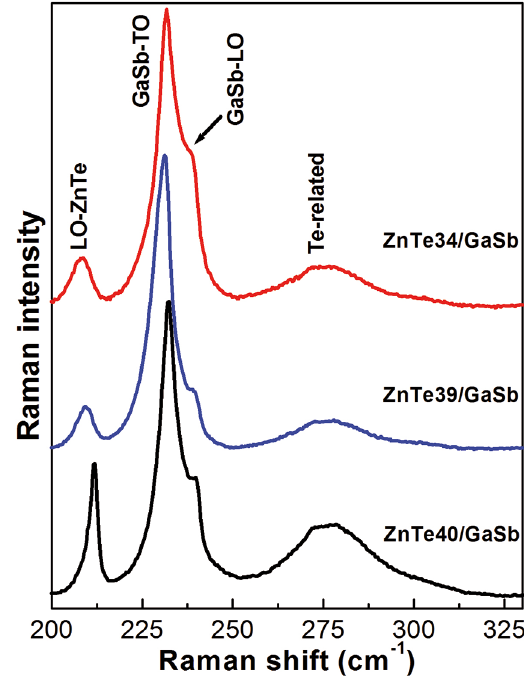
Figure 6: ZnTe Raman measurements of samples grown on GaSb. LO-ZnTe peak shows a dependence with the growth temperature as is illustrated in Table 1.